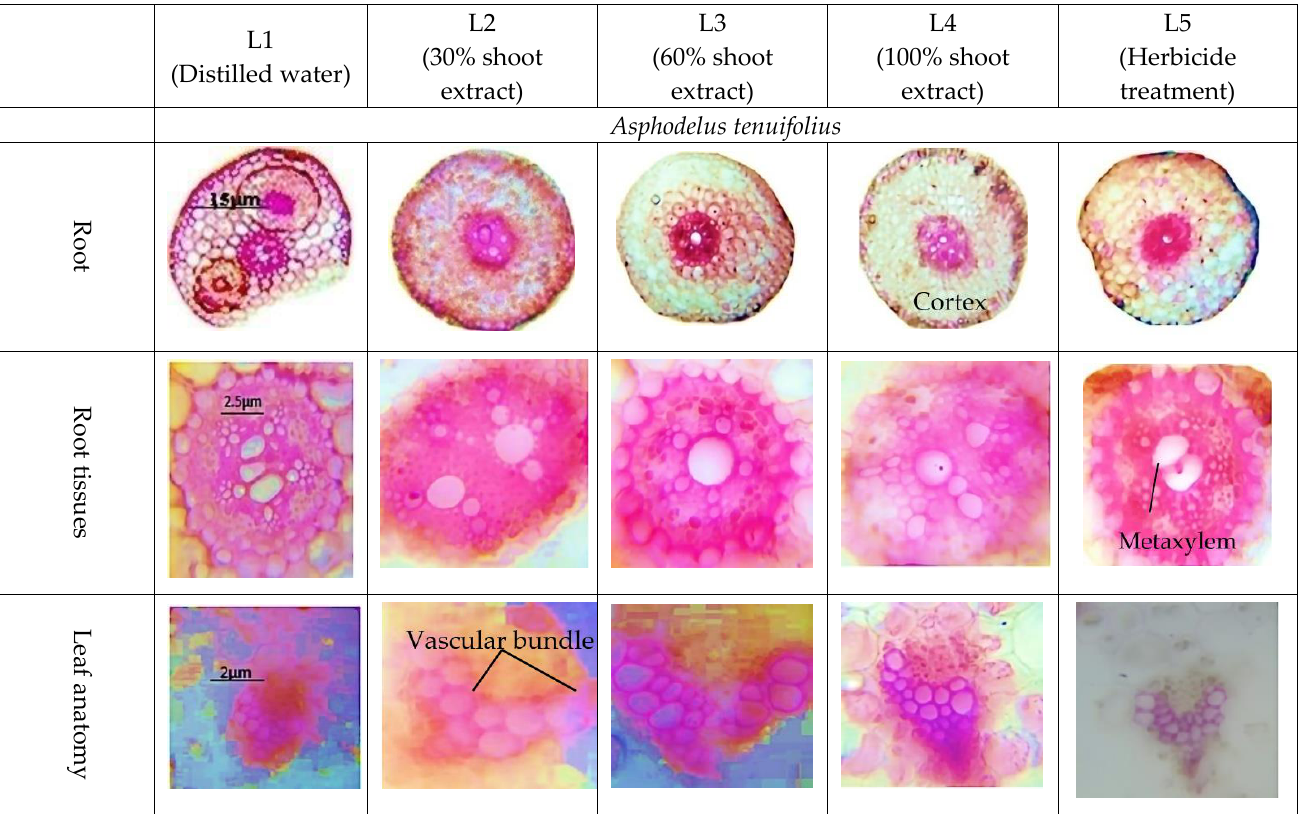
Figure 2. Effect of shoot extract of T. portulacastrum and herbicide on leaf anatomical parameters of A. tenuifolius and C. arvensis. L1 = distilled water; L2 = 30%; T3 = 60%; T4 = 100%; and T5 = herbicide treatment. Means followed by the same letter did not significantly differ at p ≤ 0.05 according to LSD test.